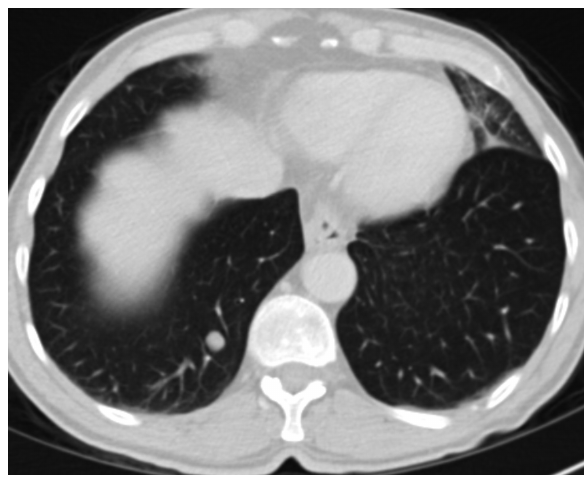
Figure 1. An axial chest CT section of a 57-year-old male patient shows an 11 × 10 mm nodule in the right lower lobe posterobasal segment. CT, computed